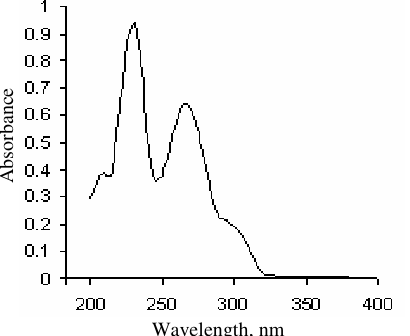
Figure 2 . UV spectrum of Acipimox in distilled